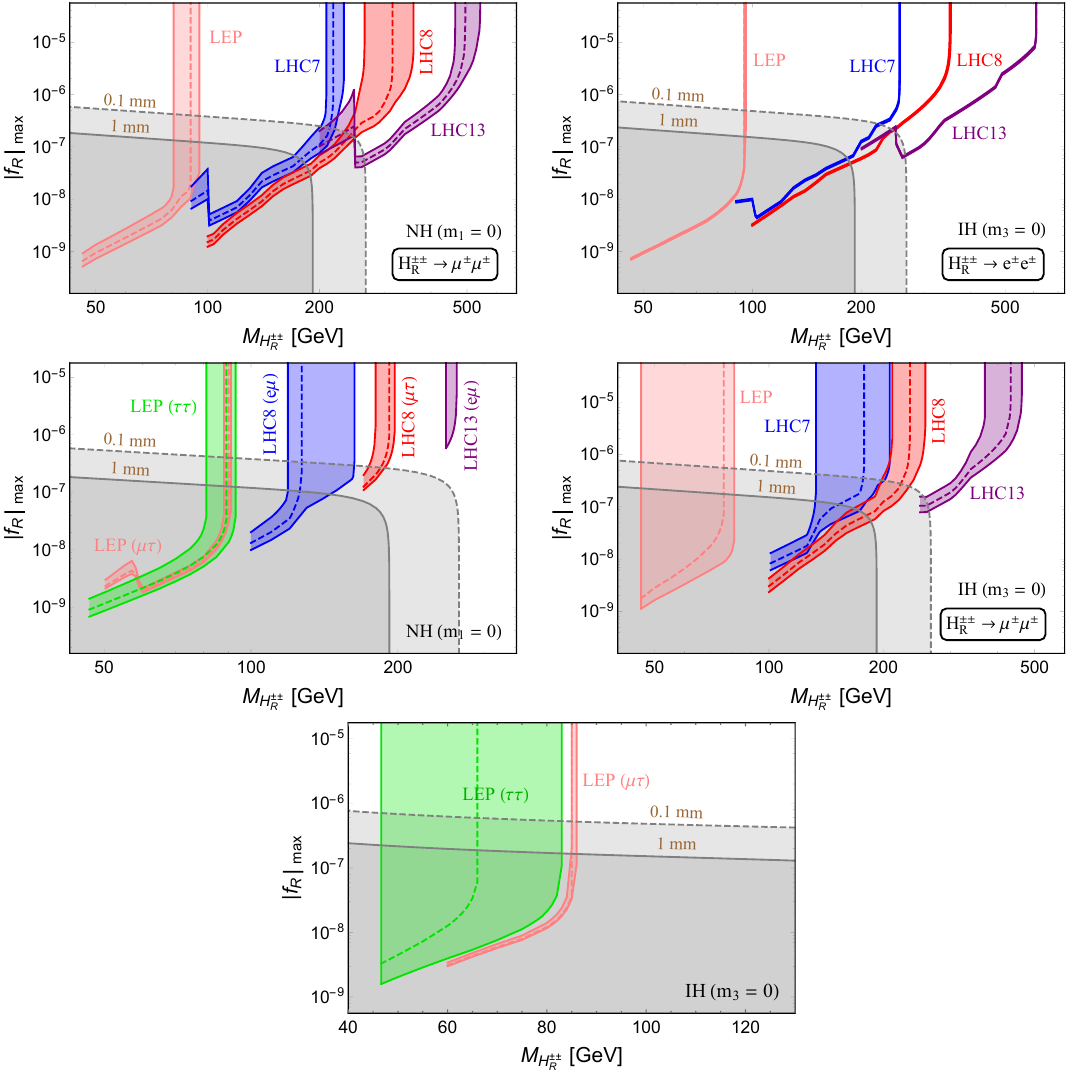
Figure 14 . Same-sign dilepton lower limits on M in the LRSM from the data in (cid:12)gure 12, as H (cid:6)(cid:6) R functions of the value of largest Yukawa coupling j f R j max for the lightest neutrino mass m 0 = 0. The upper and middle left panels are for the NH case, in the (cid:22)(cid:22) channel and e(cid:22) , (cid:22)(cid:28) and (cid:28)(cid:28) channels. The upper and middle right panels are the limits for the IH case in the ee and (cid:22)(cid:22) channels. The bottom panel are for the IH case in the (cid:22)(cid:28) and (cid:28)(cid:28) channels. The dashed curves correspond to the central values of the neutrino data in table 1, and the colorful bands are due to the 3 (cid:27) uncertainties. The darker and lighter gray regions correspond respectively to the proper decay length c(cid:28) 0 ( H (cid:6)(cid:6) ) > 1 mm and 0.1 mm; within these regions the prompt dilepton limits are R not